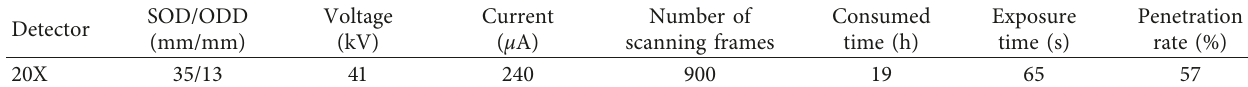
Table 1: Setting of scanning parameters of the X-ray 3D microscope.